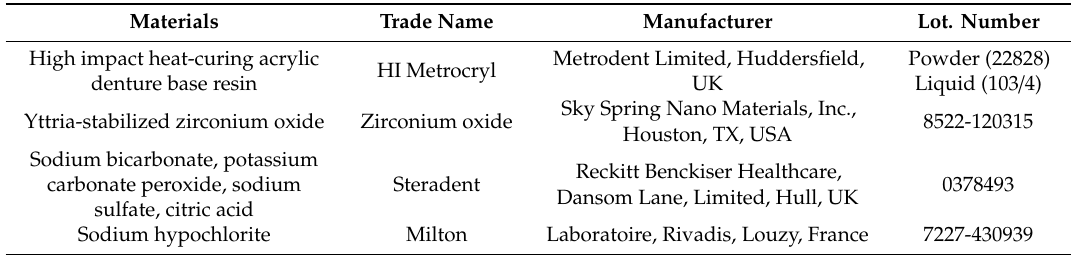
Table 1. Materials and denture cleaners used in this